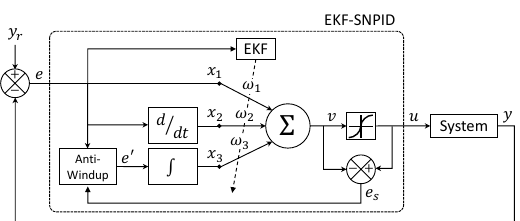
Figure 5. Adaptive single neuron anti-windup PID control scheme. EKF-SNPID: the proposed adaptive neuron PID controller trained with EKF algorithm.